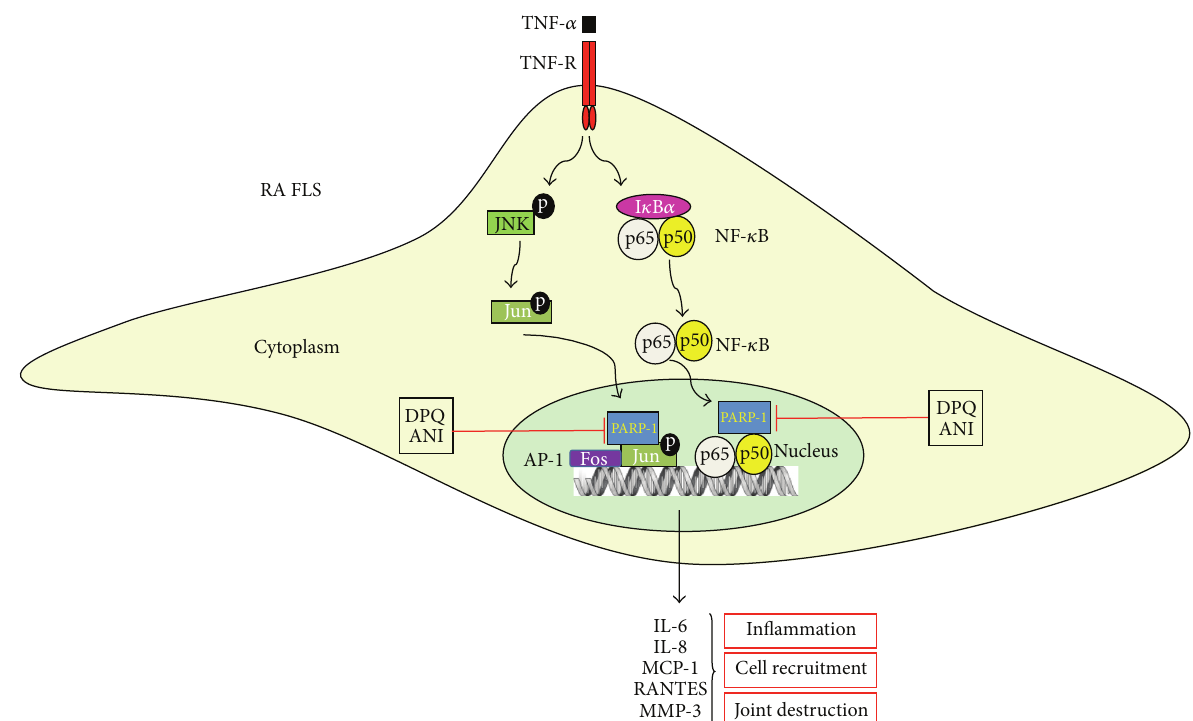
Figure 1: Effect of PARP-1 on the TNF- 𝛼 induced production of inflammatory mediators in RA FLS . TNF- 𝛼 stimulation induces the activation and the translocation to the nucleus of the transcription factors NF- 𝜅 B and AP-1. In the nucleus, PARP-1 enzymatic activity and/or direct protein interaction enhances the transcriptional activity of both NF- 𝜅 B and AP-1, leading to the production of inflammatory